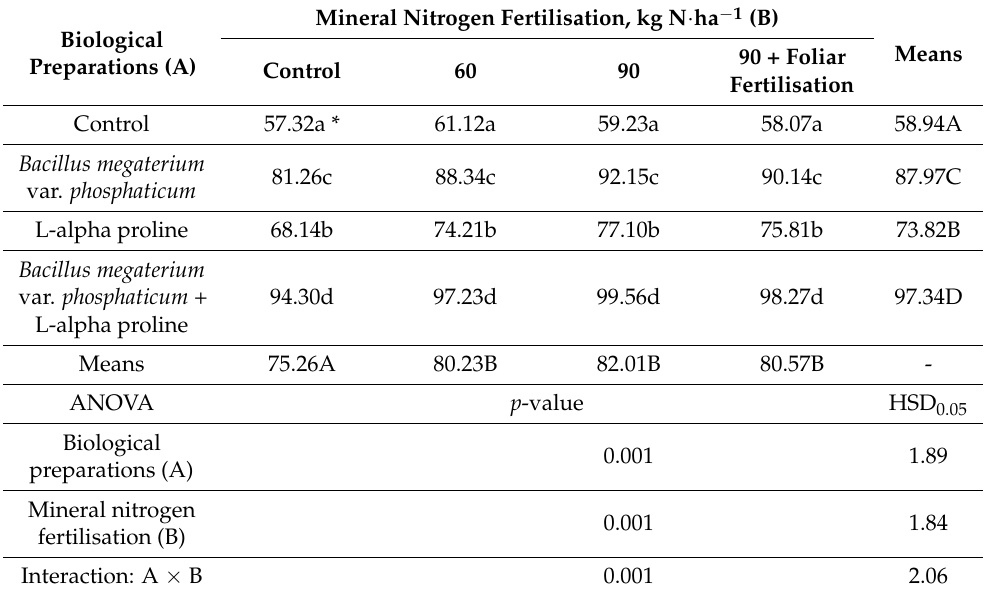
Table 8. Fe content in spring wheat straw (means across 2017–2019), mg · kg − 1 d.m.